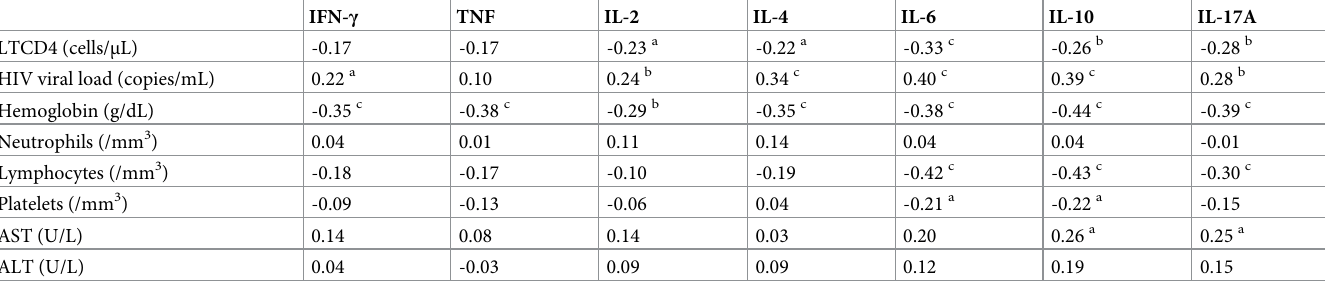
Table 3. Correlation coefficients between serum cytokine levels and general laboratory data of all